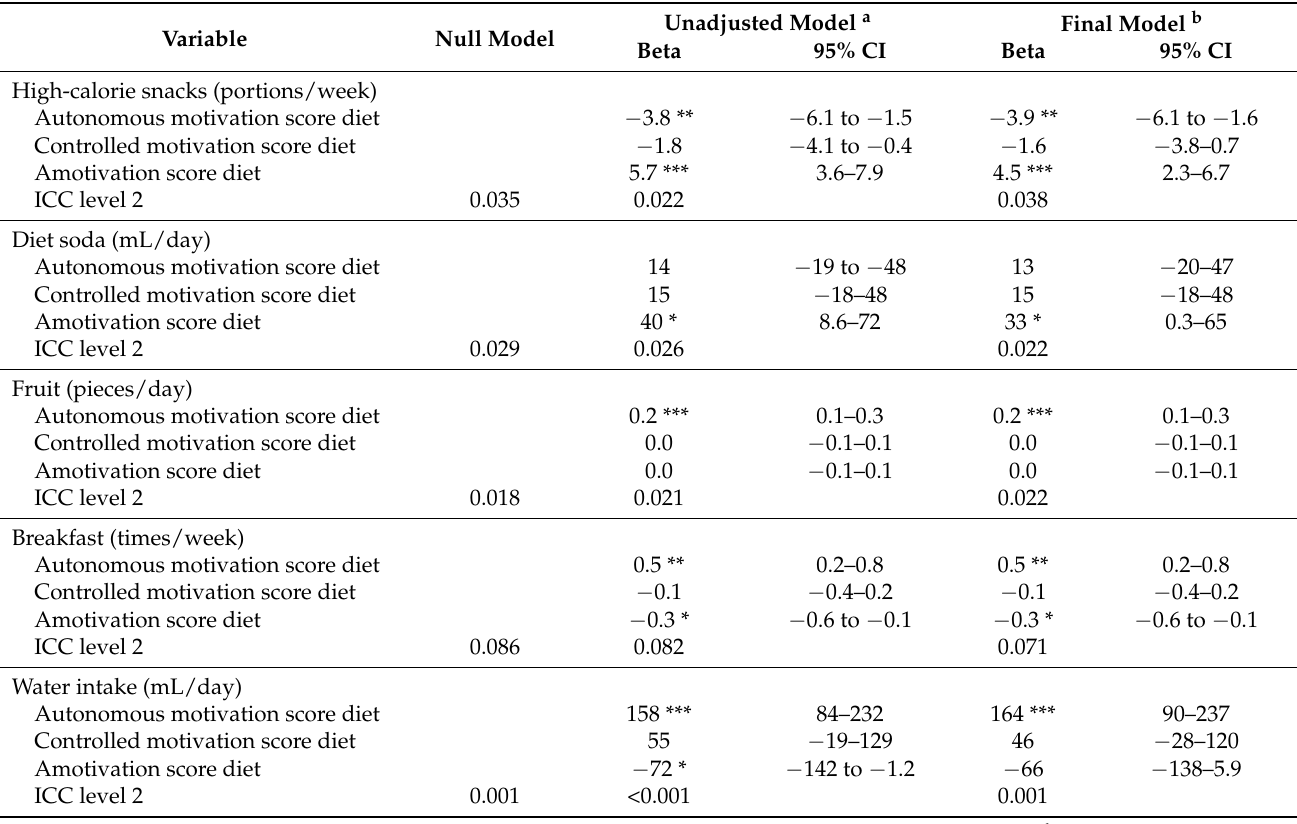
Table 4. Multilevel linear regression analyses of the association between types of motivation and dietary behaviors (N = 809).